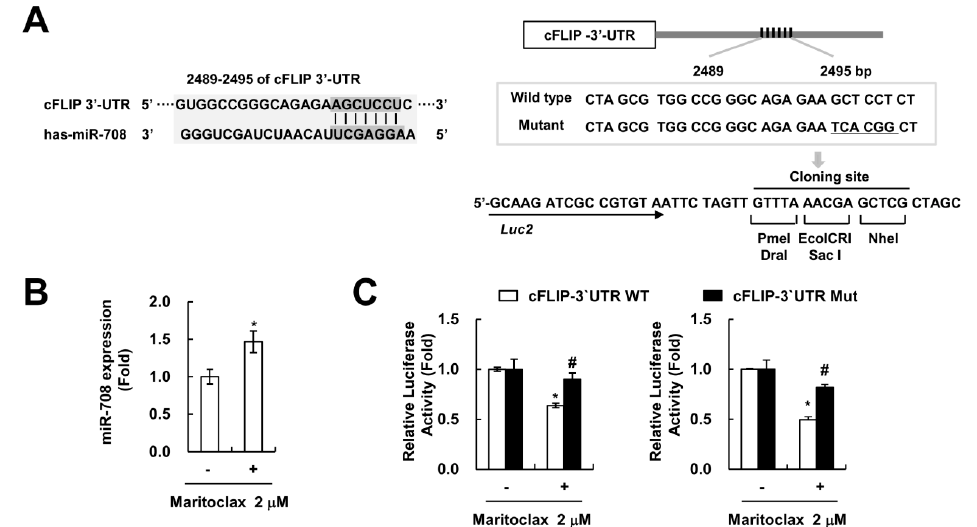
Figure 6. Maritoclax induces miR-708 mediated cFLIP downregulation. ( A ) miR-708 binding sites in in cFLIP 3 (cid:48) -UTR, and the mutated nucleotides in cFLIP 3 (cid:48) -UTR mutant (right panel). ( B ) Caki cells were treated with 2 µ M maritoclax for 24 h. The miR-708 expression levels were analyzed by qPCR. ( C ) Luciferase constructs for cFLIP 3 (cid:48) -UTR wild-type (WT) and cFLIP 3 (cid:48) -UTR mutant (Mut) were transfected and then further culture for 24 h. Caki (left panel) and A549 (right panel) cells were treated with 2 µ M maritoclax for 24 h, and the luciferase activity was analyzed. − , no treatment; +, treatment. The values in graph ( B , C ) represent the mean ± SD from three independent samples. * p < 0.05 compared to the control. # p < 0.05 compared to the maritoclax-treated cFLIP 3 (cid:48) -UTR WT by ANOVA and Student-Newman-Keuls